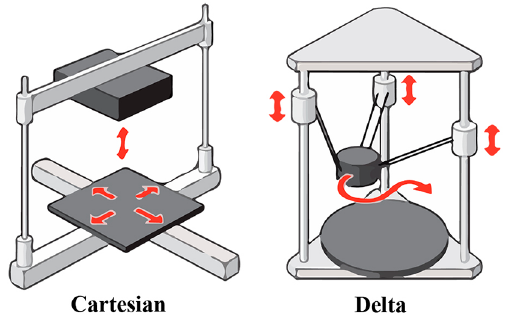
Figure 1. Schematic of cartesian and delta printers. Source: Earls e Baya (2014).